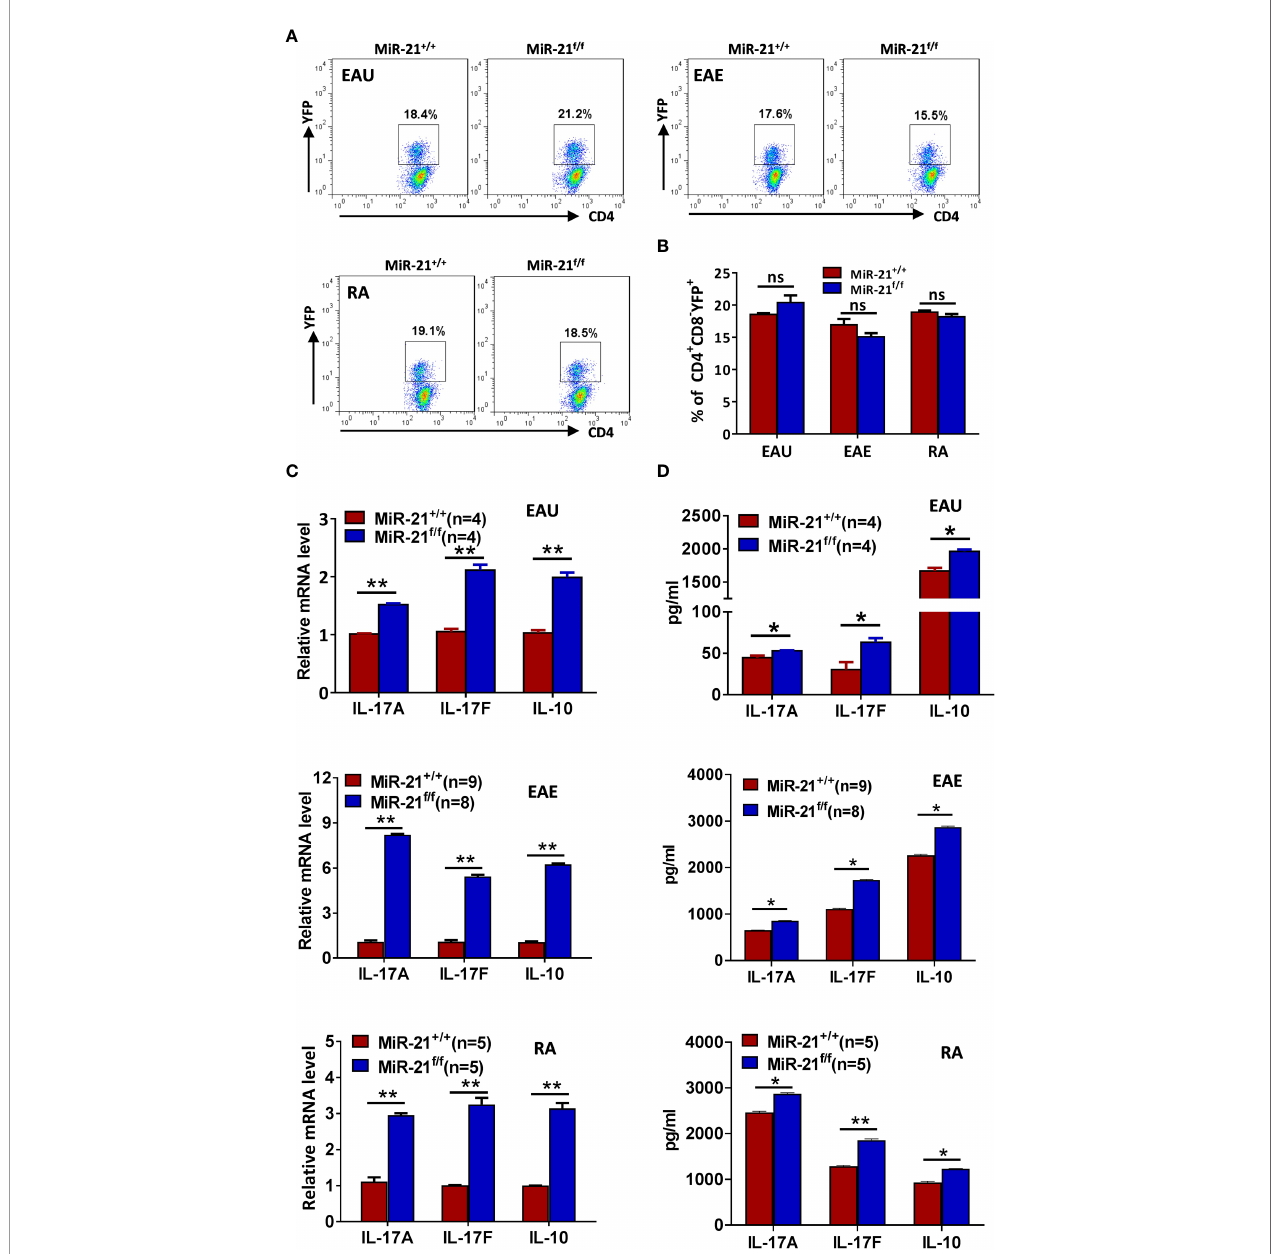
FIGURE 7 | MiR-21-de fi cient Treg cells that have experienced in fl ammatory environment in vivo produce signi fi cant more IL-17 and IL-10. Mouse models of EAU, EAE, and RA were established and mice were sacri fi ced as in Figure 7 . (A, B) The percentage of CD4 + CD8 - YFP + Treg cells in the CLN (for EAU and EAE) and ILN (for RA) were determined by fl ow cytometry (A) . Cells shown were gated on CD4 + CD8 - cells. The quanti fi cation of the percentage of CD4 + CD8 - YFP + Treg cells was shown in (B). (C, D) CD4 + CD8 - YFP + cells were fl ow sorted from the CLN (for EAU and EAE) and ILN (for RA). Total RNA was extracted and the mRNA expression of IL-17A, IL-17F, and IL-10 was determined by quantitative RT-PCR (C) . In addition, sorted CD4 + CD8 - YFP + cells were cultured with a -CD3 plus a -CD28 and IL-2 for 48 h. Culture supernatants were then collected and the protein level of IL-17A, IL-17F, and IL-10 was determined by ELISA (D) . Data are representative of two independent experiments. CLN, cervical lymph node; ILN, inguinal lymph node; ns, no signi fi cance. *p < 0.05, **p <